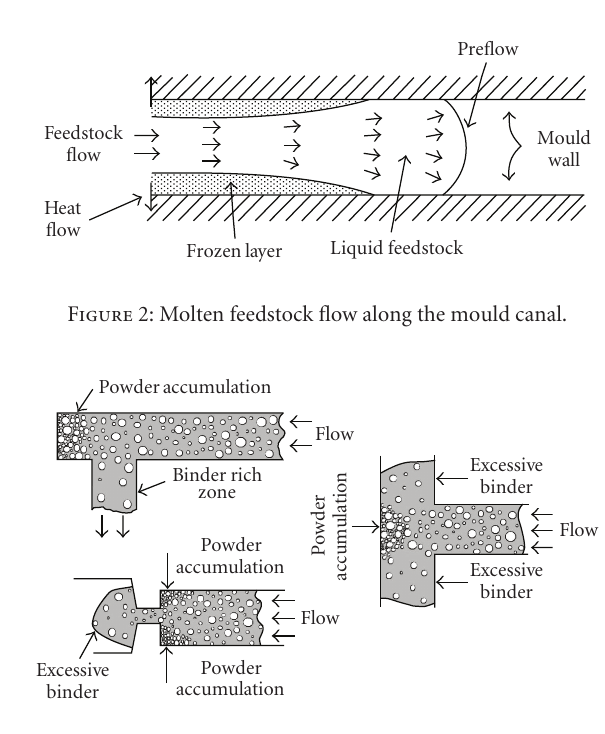
Figure 3: Separation of powder-binder during the direction change [2,